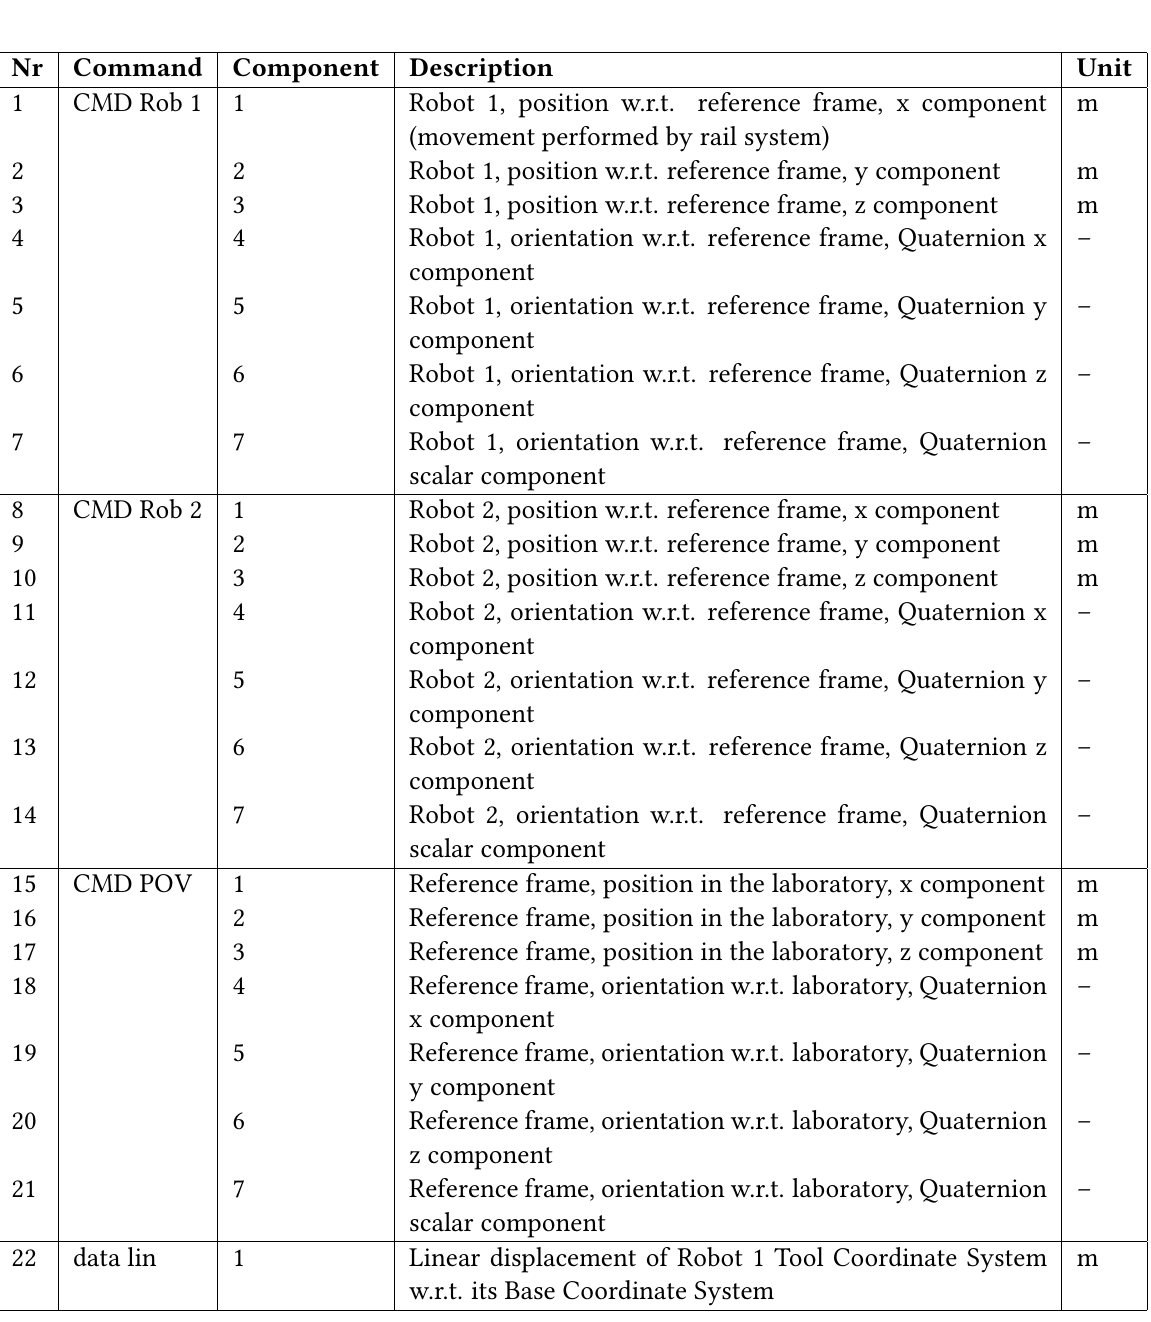
Table 9: Description of the commanding parameters in case of Clohessy Wiltshire Coordinate System